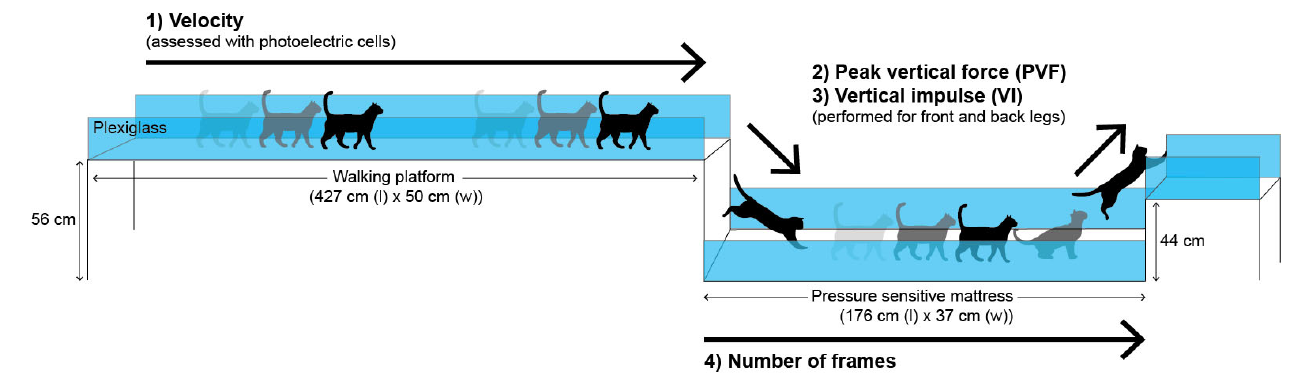
Figure 4. Illustration of the Effort Path. The cats walked/trotted across the walking ramp, jumped down onto a pressure-sensitive mattress and jumped up onto a raised ramp. Measurements were: (1) velocity (speed of movement across the walking platform), (2) peak vertical force (PVF), (3) vertical impulse (VI) as cats jumped down and up from the pressure sensitive mattress, and (4) the number of frames (reflecting the time to passing the pressure sensitive mattress). The entire path was enclosed by transparent plexiglass to allow cats to move naturally and undisturbed. The cats were positively motivated by rewards provided at the end of the Effort Path.